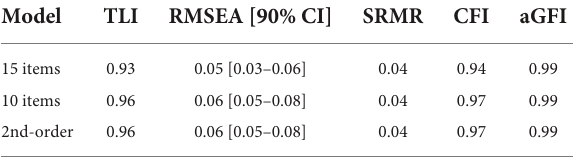
TABLE 3 Psychometric properties of the Relationship Quality Inventory for Adolescents (RQI-A) ( n 2 =